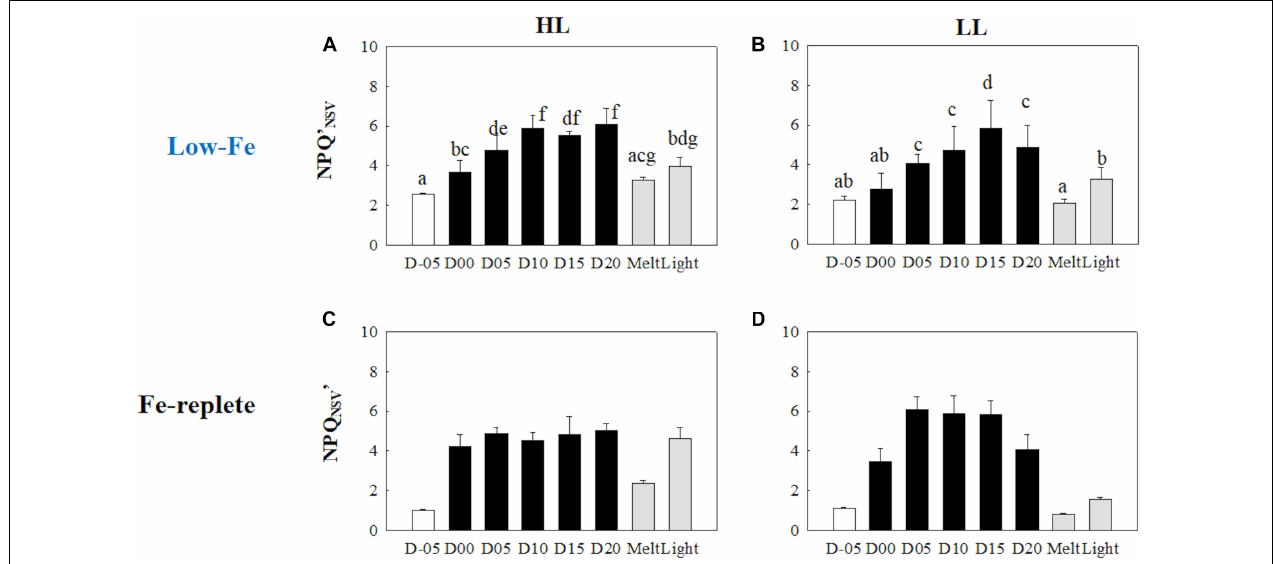
FIGURE 5 | Non-photochemical quenching based on the normalized Stern-Volmer quenching coefficient under the actinic light (150 and 30 µ mol photons m − 2 s − 1 for HL and LL, respectively) (NPQ NSV (cid:48) ) at each sampling time point during the ice tank incubation experiments. Panels (A,B) show NPQ NSV (cid:48) values of the low-Fe ice tank runs in this study, whereas panels (C,D) show those of Fe-replete ice tank runs modified from Yoshida et al. (2020). Left (A,C) and right (B,D) panels indicate data from the HL and LL treatments, respectively. Open, closed, and shaded bars indicate values of pre-freeze seawater, ice, melted seawater samples, respectively. Letters above bars in a panel indicate significant differences in values between sampling days with one-way ANOVA with Tukey’s test; there is no significant difference between values if a given letter is shown in the combination of letters of the counterparts. The D stands for “day,” while Melt and Light indicate values after melting and light exposure experiments, respectively. Error bars show 1 standard deviation ( n = 6). One-way ANOVA with Tukey’s test, HL: F ( 7 , 47 ) = 36.03, p < 0.001; LL:. F ( 7 , 47 ) = 29.12, p < 0.001. Two-way ANOVA test with Tukey’s test, Light: F ( 1 , 75 ) = 24.40, p < 0.001; Day: F ( 7 , 90 ) = 45.74, p < 0.001; Light*Day: F ( 7 , 90 ) = 34.49, p < 0.001. A significant interaction between the light availabilities and sampling time points was observed. The results of Tukey’s test, as q -values, are given in the